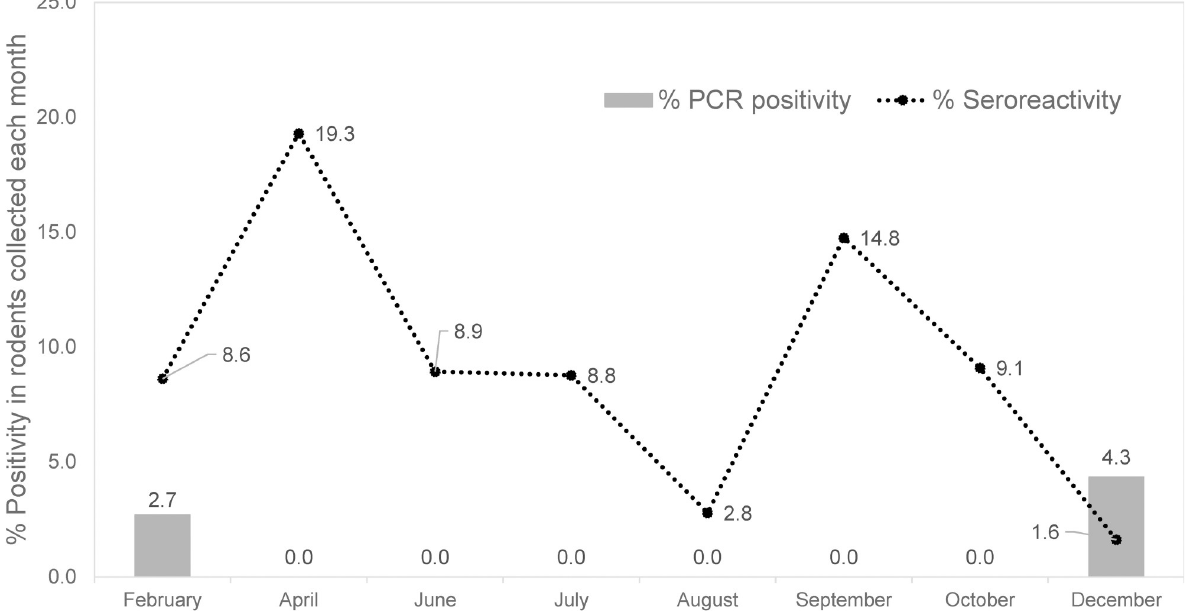
Fig 5. The percentage of positive anti- B . miyamotoi rGlpQ IgG antibody in rodents collected every other month in 2019–2020, Phop Phra district, Tak province.